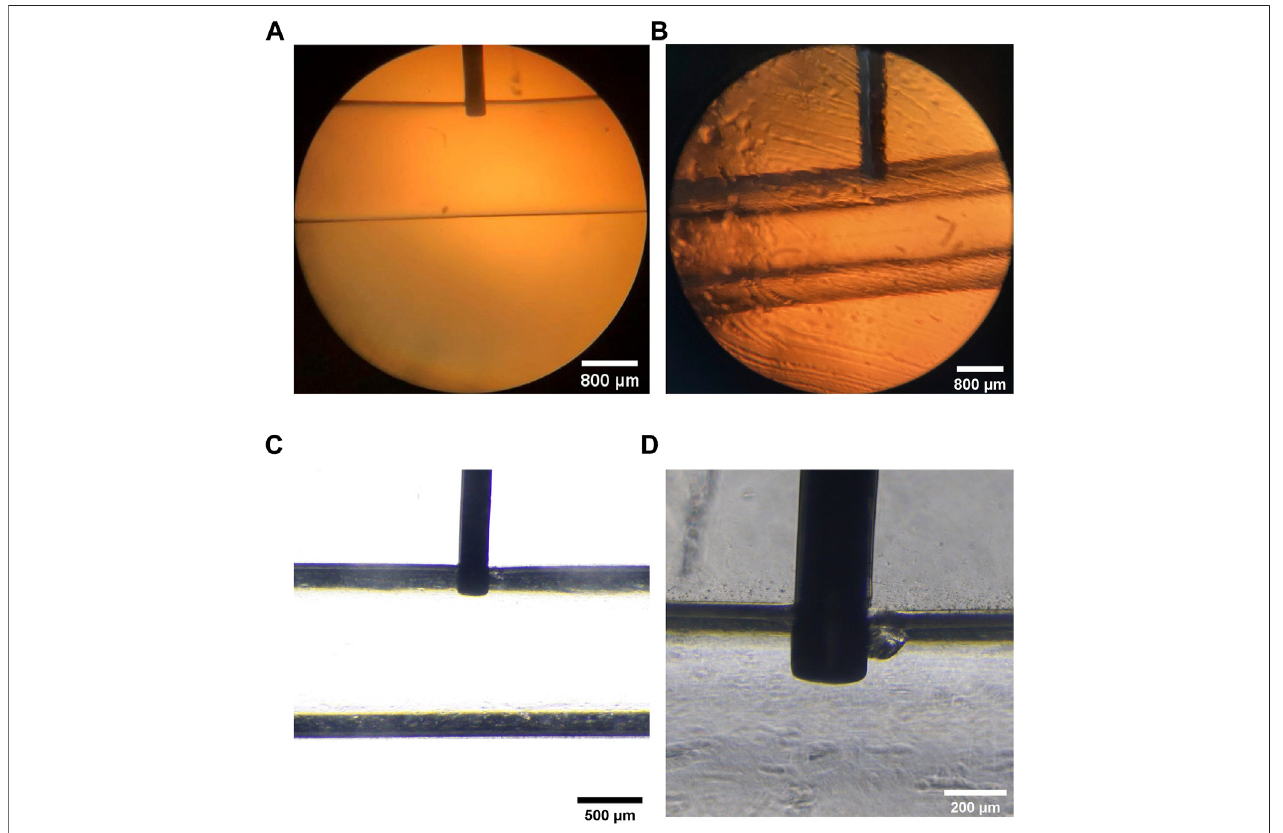
FIGURE 4 | Vertical Injection Depth of the 30 G Needle (A) Microscopic image of the PDMS fi xed block inserted a 30 G injection needle vertically, the scale is 800 μ m (B) Microscopicimageofinternalandexternalliquidandtheverticalinjectionneedle,thescaleis800 μ m (C,D) Thedepthofinjectionperpendiculartotheneedle was marked under the microscope and measured at 231.803 μ m, the scales are 500 and 200 μ m,